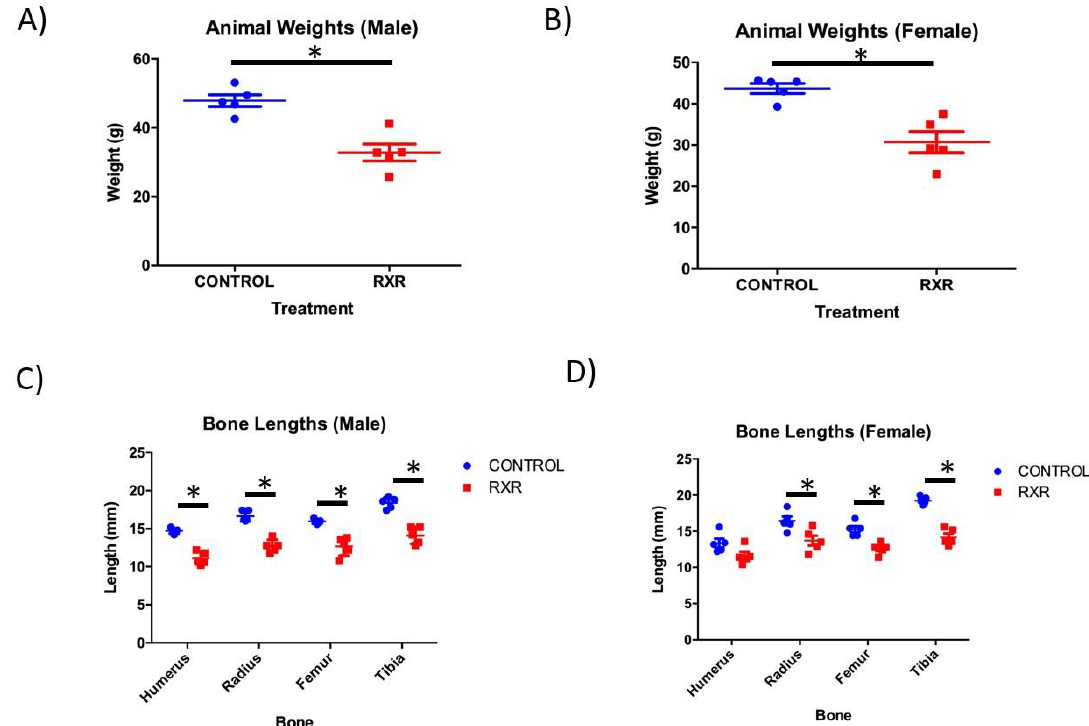
Figure 1. Retinoid X Receptor (RXR) agonist treatment results in reduced weight and bone length in rats. At P16, male ( A ) and female ( B ) animals were weighed before sacrifice ( N = 5; mean ± SEM; Mann–Whitney unpaired two tailed t -test; p < 0.005). Bone lengths were measured at P16 in male ( C ) and female ( D ) rats following sacrifice. All RXR agonist-treated bones in the males were found to be significantly shorter than control bones, and in the females, the femur, tibia, and radius treated with the RXR agonist were significantly shorter than the control bones ( N = 5; mean ± SEM; Mann–Whitney